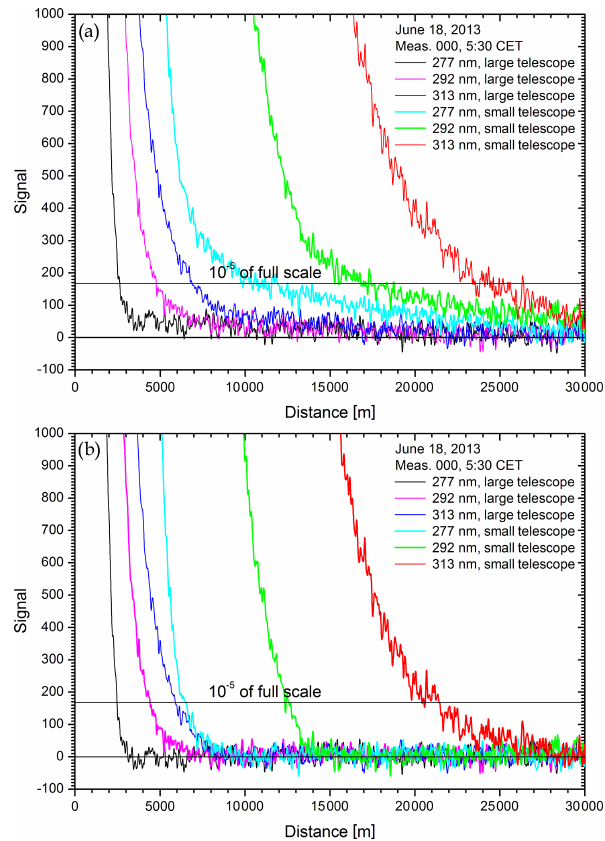
Figure 14. Strongly expanded backscatter profiles without (a) and with (b) exponential correction, recorded after the introduction of the ground-free input stage to the transient digitizers in late 2012; the 313nm signals are noisier due to the early-morning daylight background. The data are smoothed over ± 14 points (VDI vertical resolution 40m) in order to reduce the digital